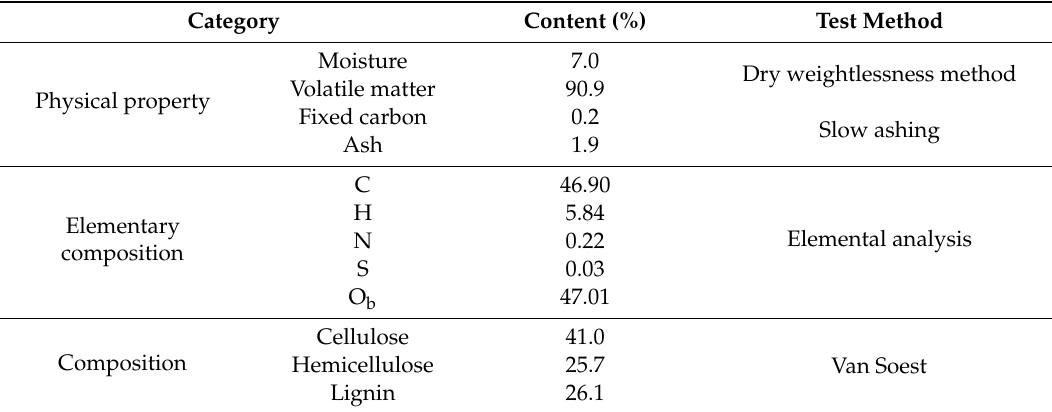
Table 2. Basic properties of bamboo.